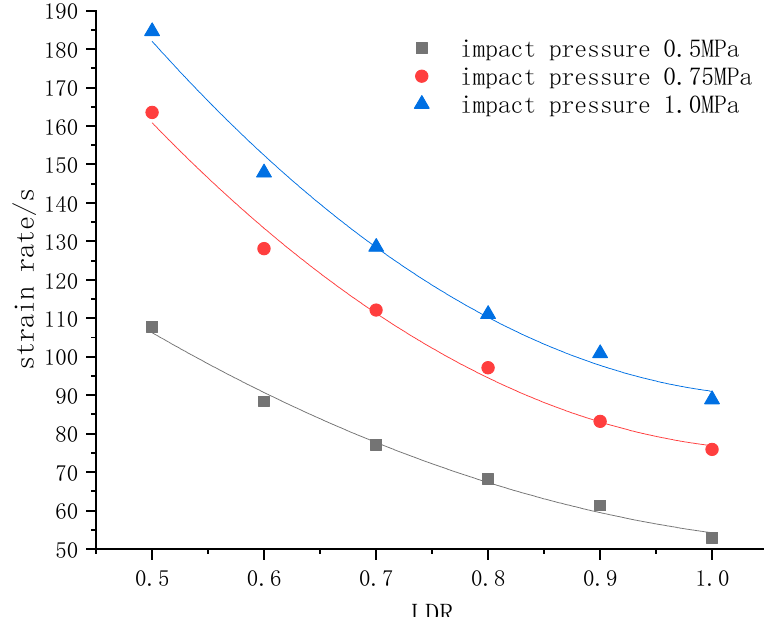
Figure 6. Influence of size on specimen crushing.